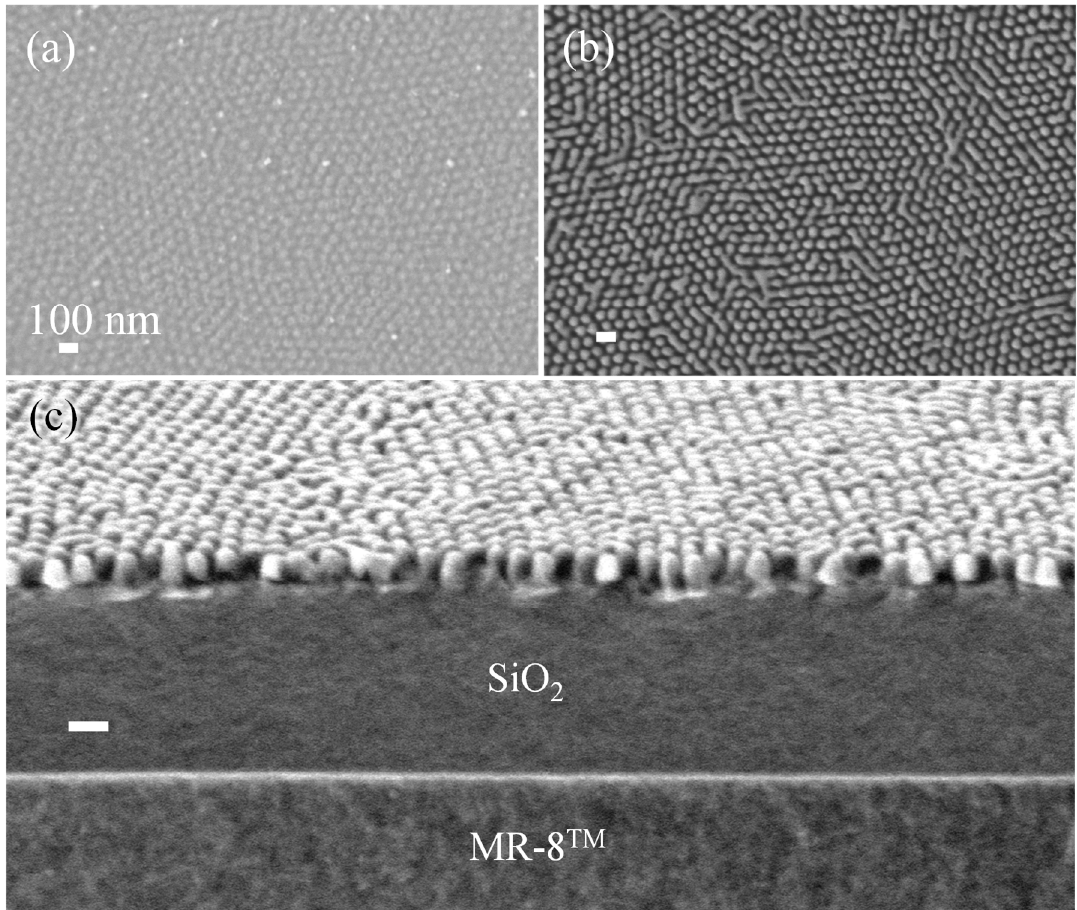
Figure 6. SEM images of AlO x /ZnO nanocylinders over an SiO 2 /MR-8 polymer substrate after ( a ) continuous 3 min of CHF 3 RIE, ( b ) 14 min of loop CHF 3 RIE. ( c ) Cross-sectional view of a textured SiO 2 surface generated with the process shown in (b). Scale bar is 100 nm in all images.